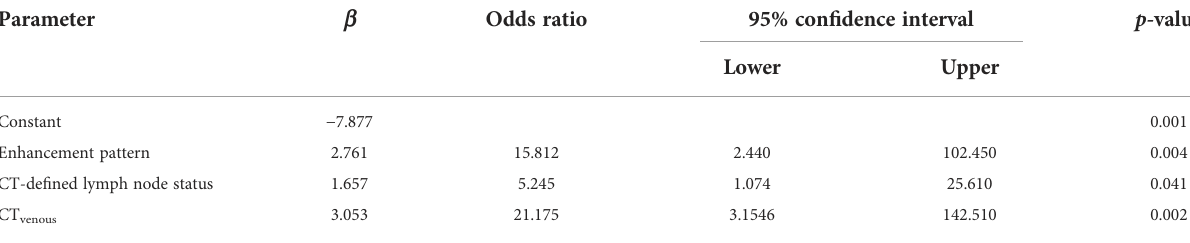
TABLE 3 Multivariate analysis in identifying LELGC from